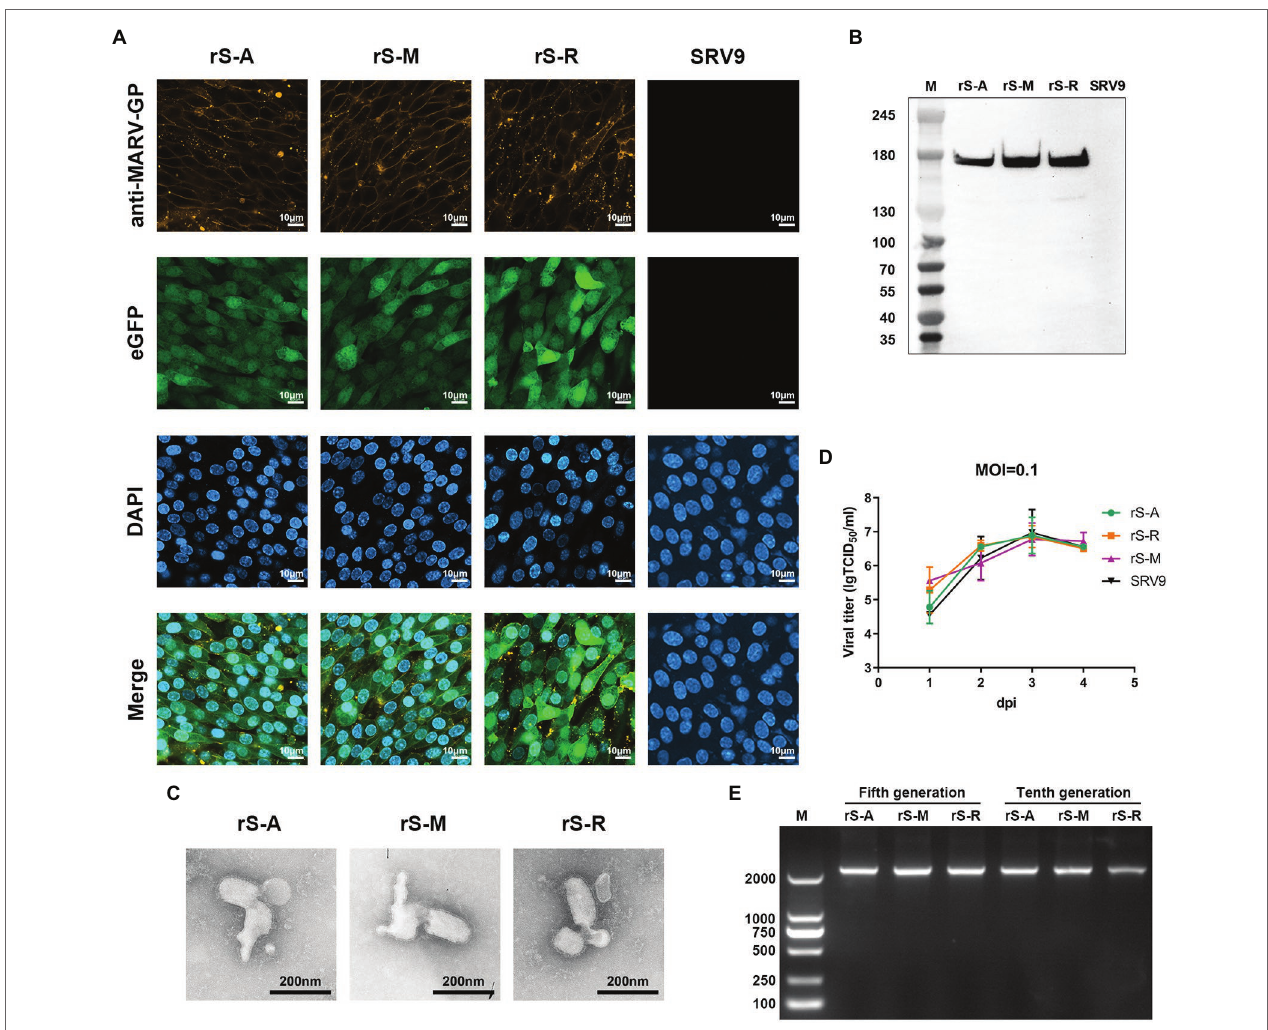
FIGURE 5 | Properties of pseudoviruses (A) Confocal microscopy analysis of BHK cells infected with the recombinant virus at MOI = 1 for 72 h. BHK cells were not permeabilized. The expression of the eGFP reporter gene was verified using excitation light with a wavelength of 488 nm. According to the budding process of RABV, the infected cells can express MARV GP. Therefore, the recombinant virus was analyzed using the rabbit serum (1:100) corresponding to the strain and the AF594-conjugated secondary antibody (1:200), respectively, under the channel of excitation light wavelength of 590 nm. Nuclei were labeled with DAPI. (B) Western blot identification of the recombinant virus. Using a 200-fold dilution of MR191 to incubate with PVDF membrane, the expression of MARV GP by the recombinant virus was verified at the protein level. (C) The proper morphology of the pseudovirus under transmission electron microscopy. The scale bar is 200 nm. (D) One-step growth curves of three pseudoviruses compared to the parent virus. After the parent and recombinant viruses were inoculated into BSR cells at MOI = 0.1, the virus titers were detected from the first day to the fourth day. In 2-way ANOVA analysis, the titer of rS-M at 1dpi was slightly higher than that of other viruses, and there was a difference compared with SRV9 p = 0.0135. Other viruses were not different from SRV ( p > 0.05). (E) RT-PCR identified the stability of the MARV GP gene insertion recombinant